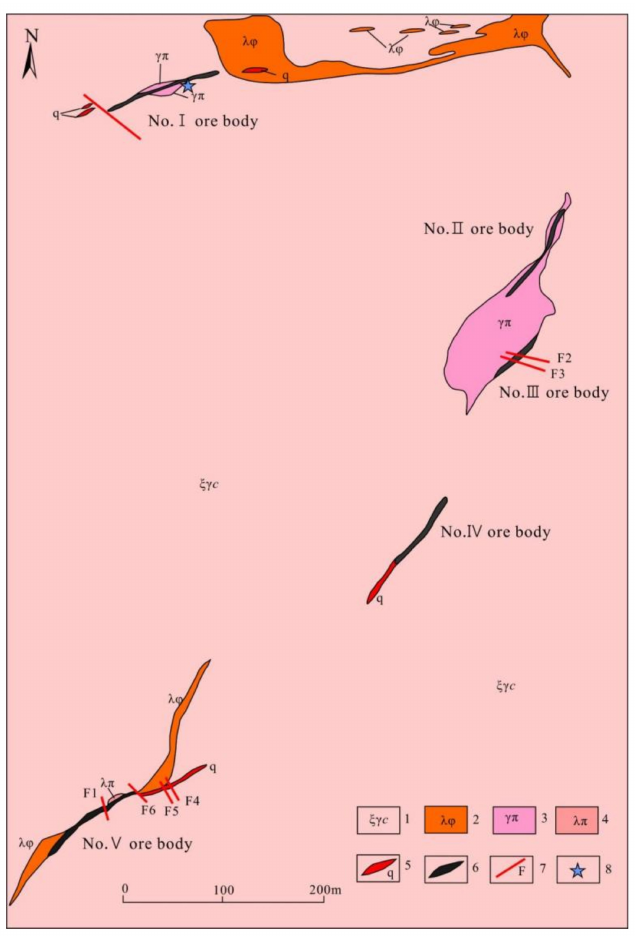
Figure 2. Geological map of Sayashk Sn mining area. 1—medium fine-grained alkaline granite; 2—quartz albite porphyry; 3—granite porphyry; 4—quartz porphyry; 5—quartz vein; 6—tin ore body; 7—fault; 8—sampling